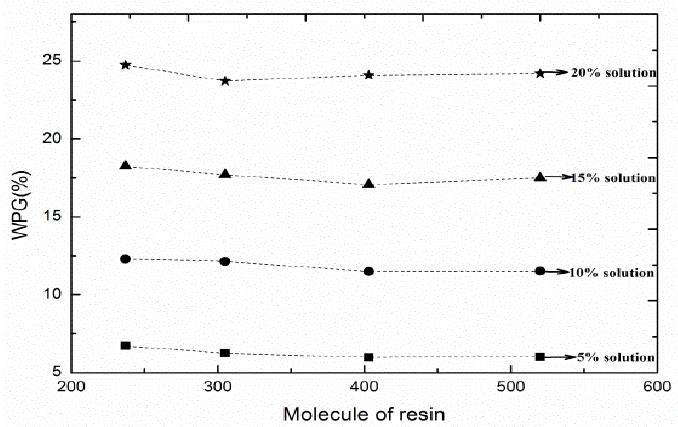
Figure 2. The weight percent gain (WPG) of wood samples treated with PF resins.